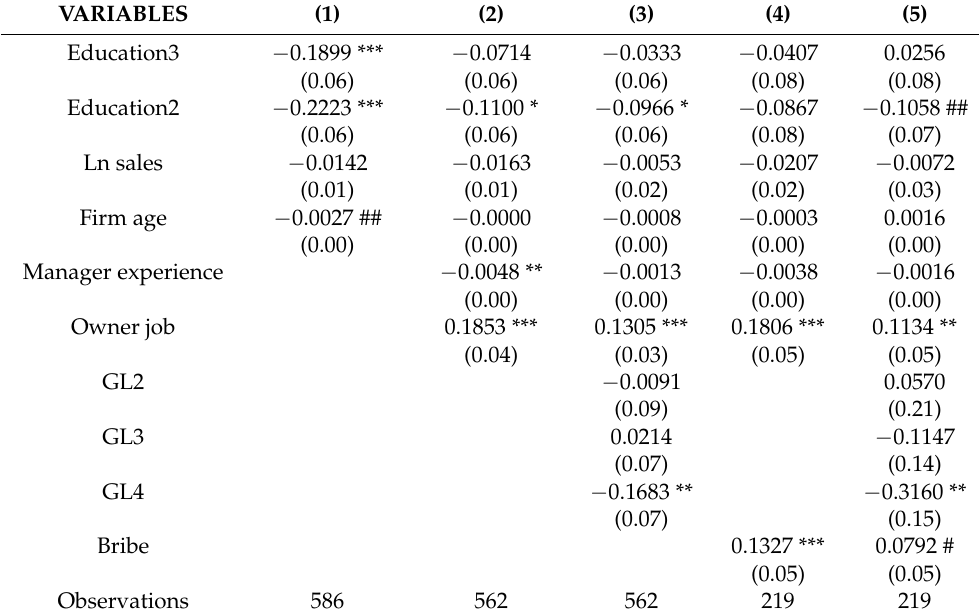
Marginal effects of factors affecting female entrepreneurship for financially con- strained